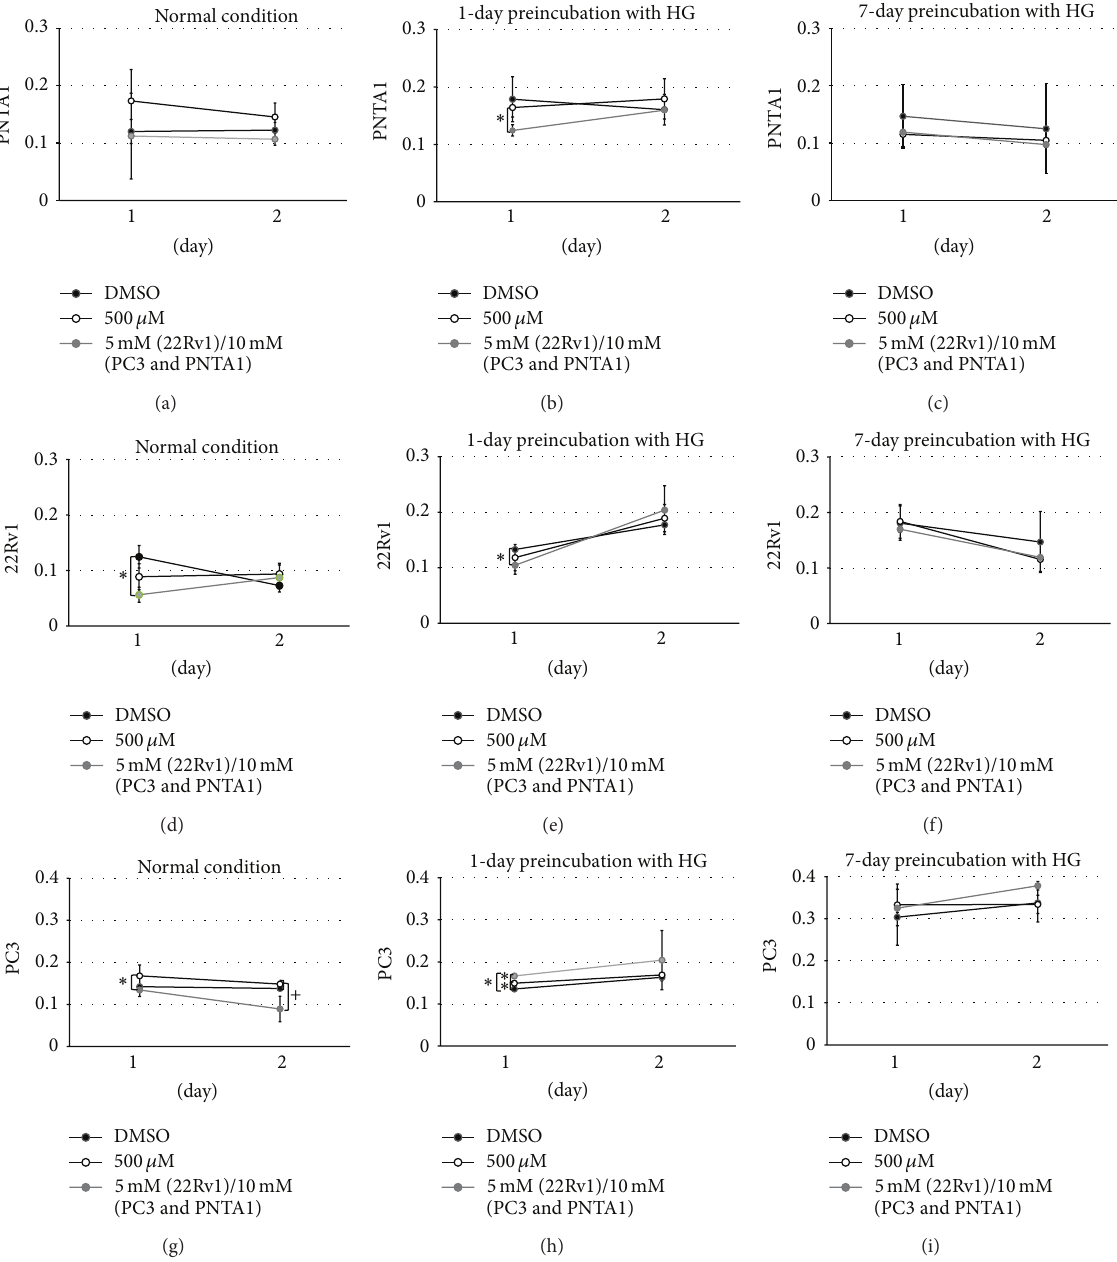
Figure 6: MTT assay (absorbance values) for cell proliferation for PNTA1 ((a), (b), and (c)), 22Rv1 ((d), (e), and (f)), and PC3 cells ((g), (h), and (i)) under normal conditions ((a), (d), and (g)), 1 day of preincubation with hyperglycemic medium ((b), (e), and (h)), 7 days of preincubation with hyperglycemic medium ((c), (f), and (i)), and treatment with DMSO, 500 𝜇 M, 5 mM, or 10 mM of MLT for 1 and 2 days. ∗ represents significant differences among the different concentrations of melatonin exposure for 1 day (parametric data). + represents significant differences among the different concentrations of melatonin exposure for 2 days (parametric